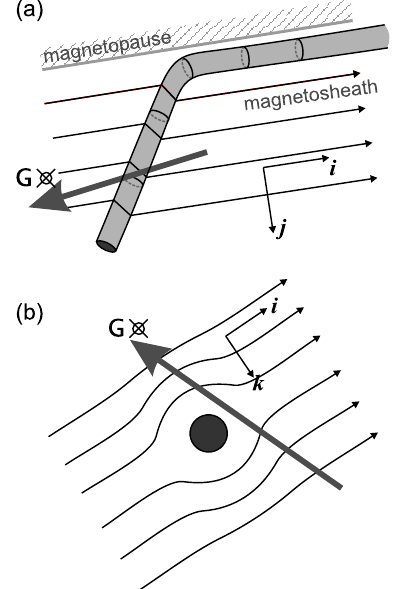
Fig. 8. An artistic rendering of a possible flux tube geometry that would excite localised boundary normal field variations like those measured at 15:18 UT and presented in Fig. 6. Panel (a) portrays the event in a plane perpendicular to the magnetopause and panel (b) portrays the event in the plane of the